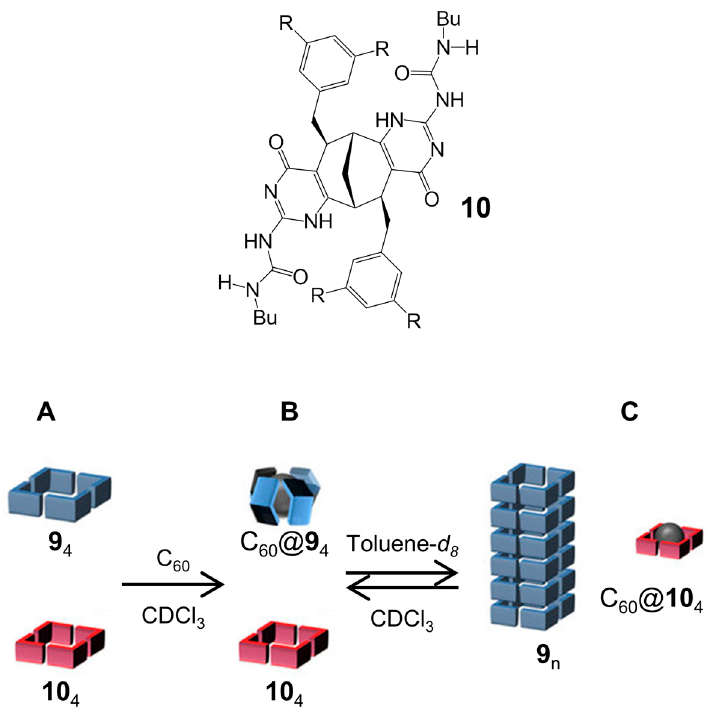
Figure 9. Monomer 10 ; schematic representation of: ( A ) tetrameric cyclic aggregates in CDCl 3 ; ( B ) capsule-like insertion complex C 60 @ 9 4 and tetramer 10 4 , in CDCl 3 ; and ( C ) capsule-like insertion complex C 60 @ 10 4 and nanotubular structure 9 n , in toluene- d 8 . Partially reproduced with permission from Ref. [48] Copyright Nature Publishing Group, 2017).